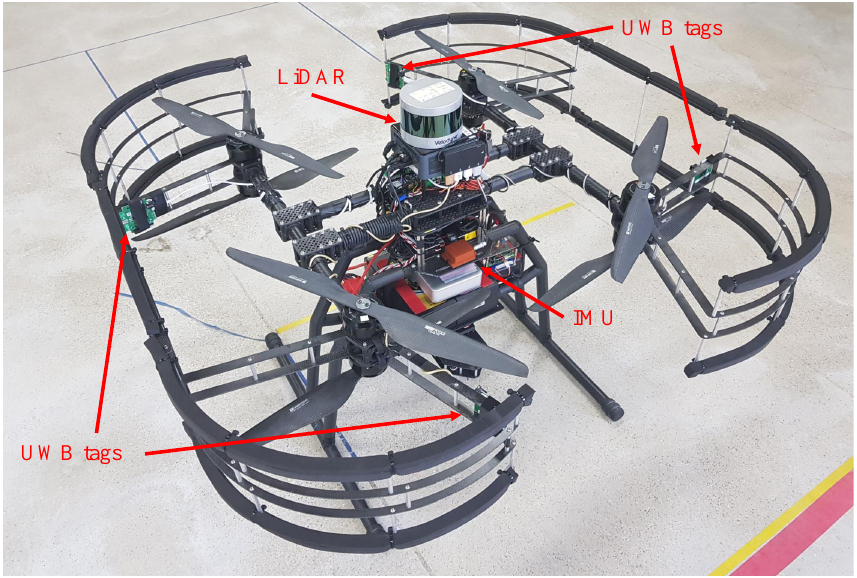
Figure 3. The proposed UAV platform equipped with four UWB tags, an IMU sensor, and a LiDAR sensor for groundtruth measurement. Table 1. The UWB tag positions relative to the UAV’s body center.